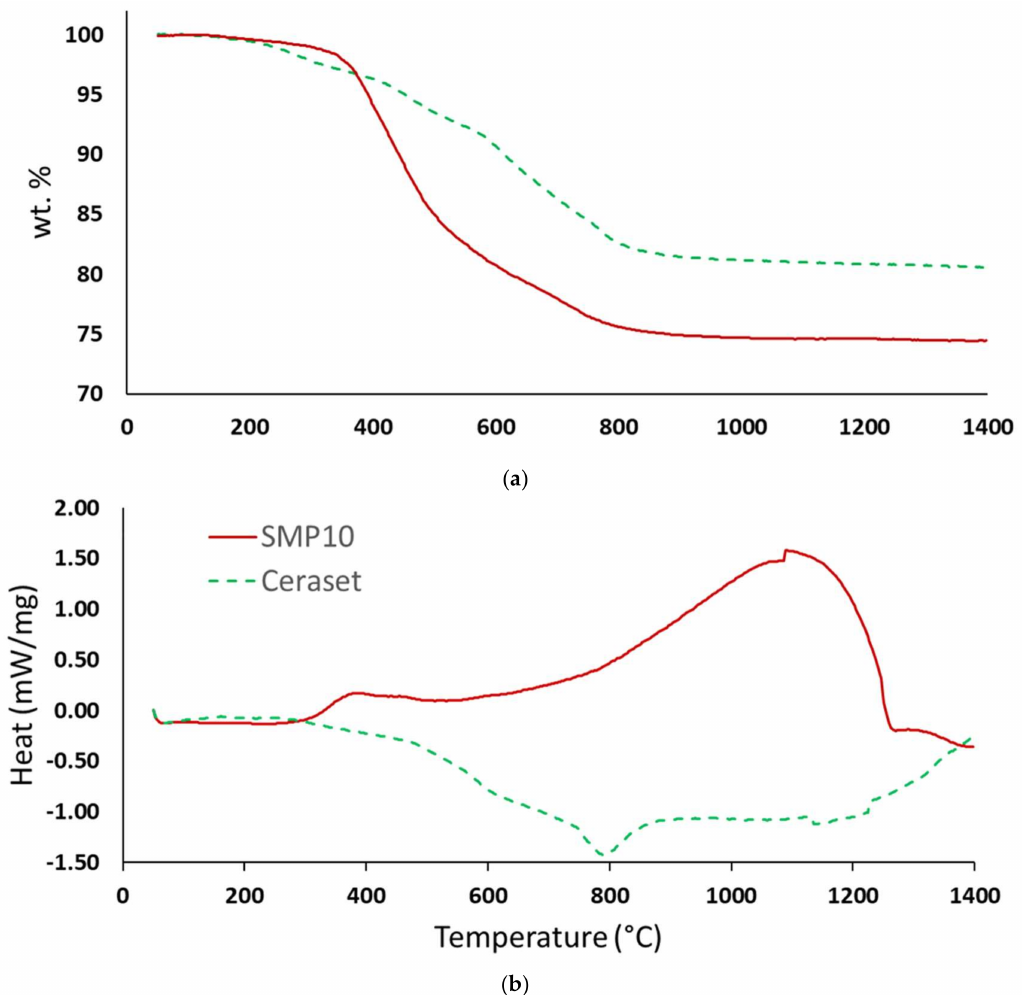
Figure 10. TGA ( a ) and DSC ( b ) of UV laser crosslinked SMP10 (solid red curves) and Ceraset (dashed green